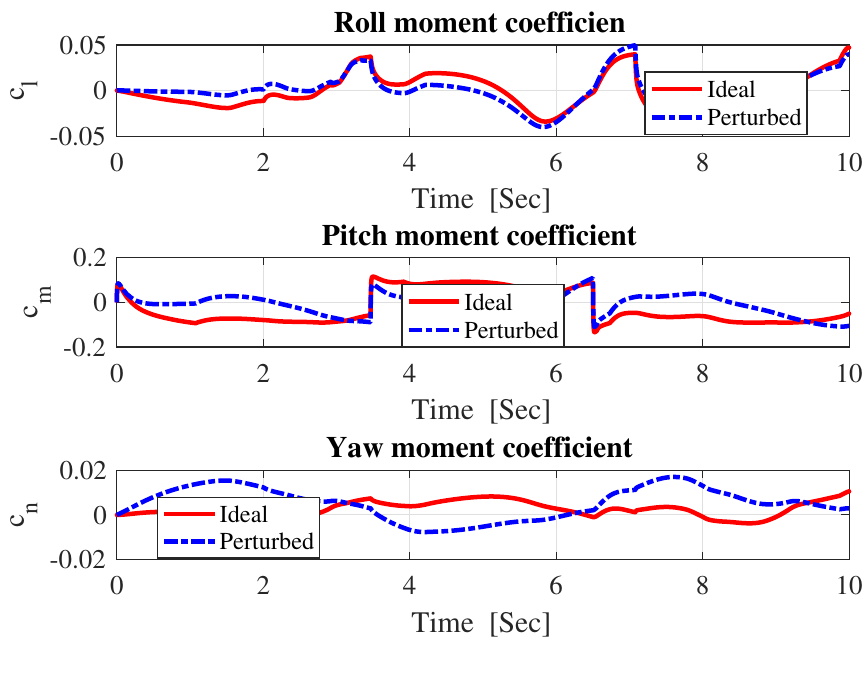
Figure 10. Moments coefficient perturbation.